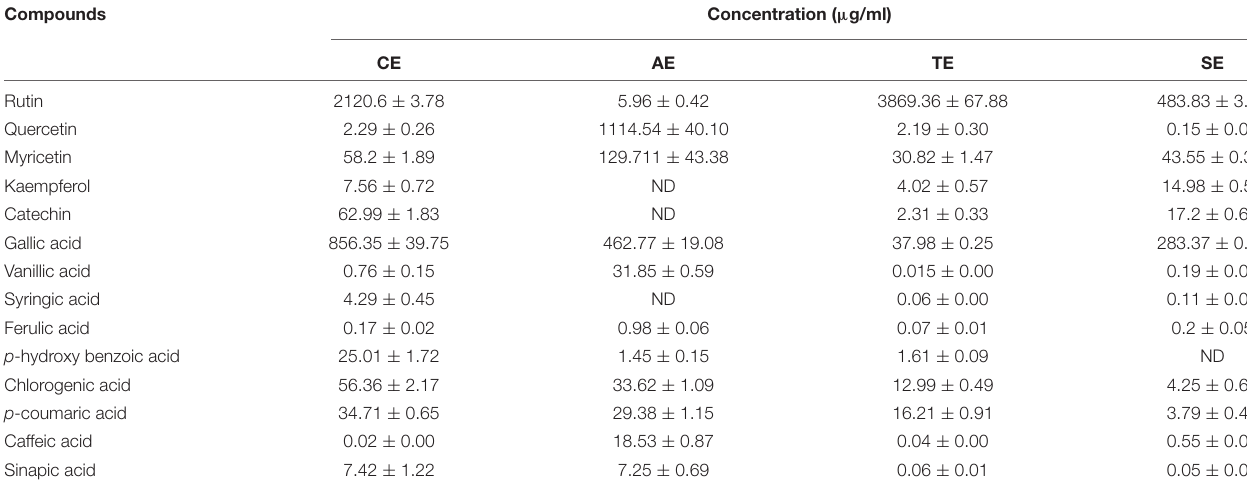
TABLE 2 | Phenolic acids and flavonoids, determined in methanolic extracts of castor (CE), artemisia (AE), wheat (TE), and sorghum (SE) by HPLC. Compounds